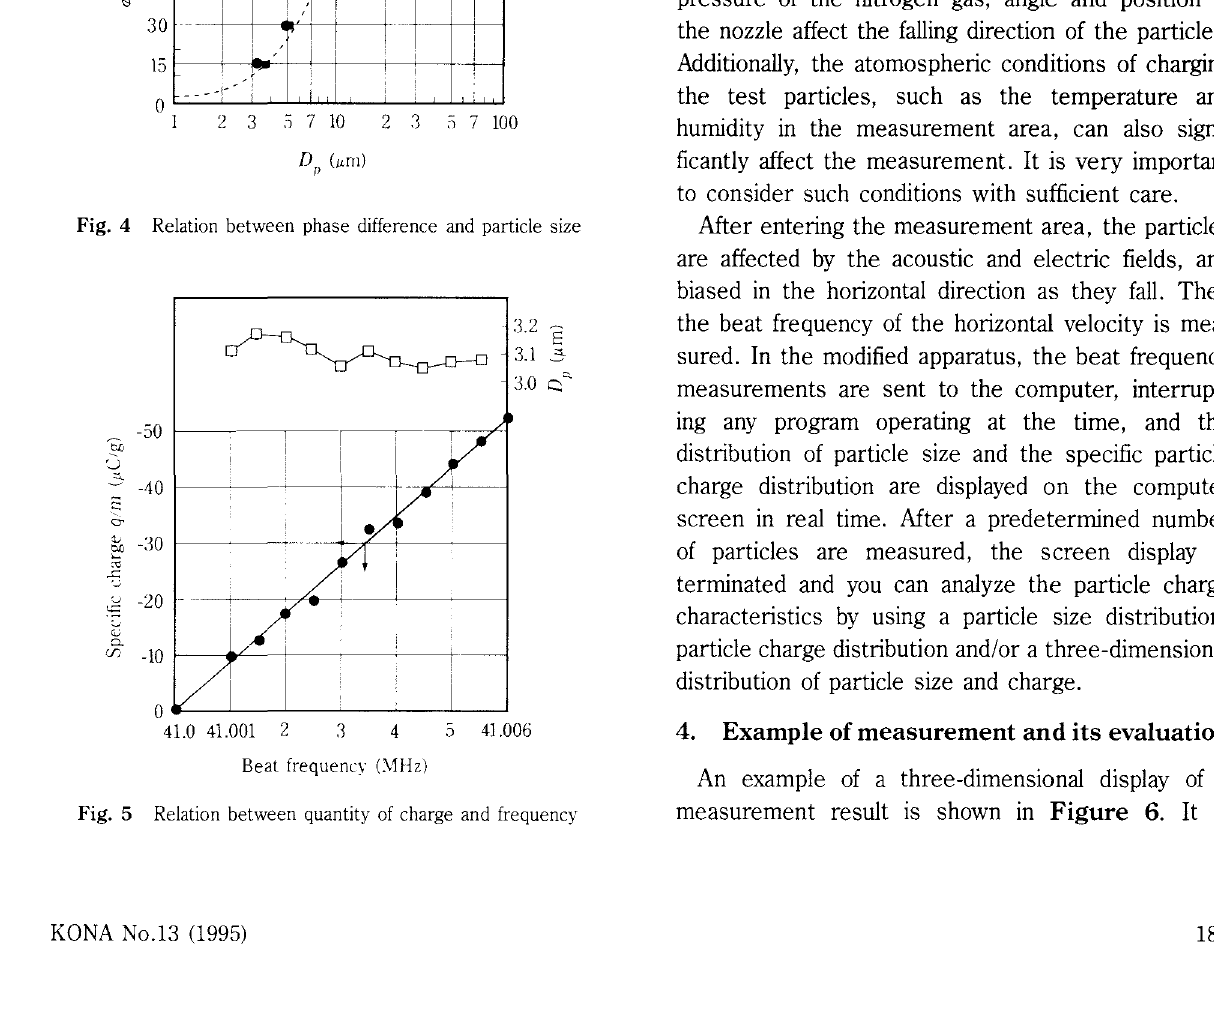
Fig. 4 Relation between phase difference and particle size